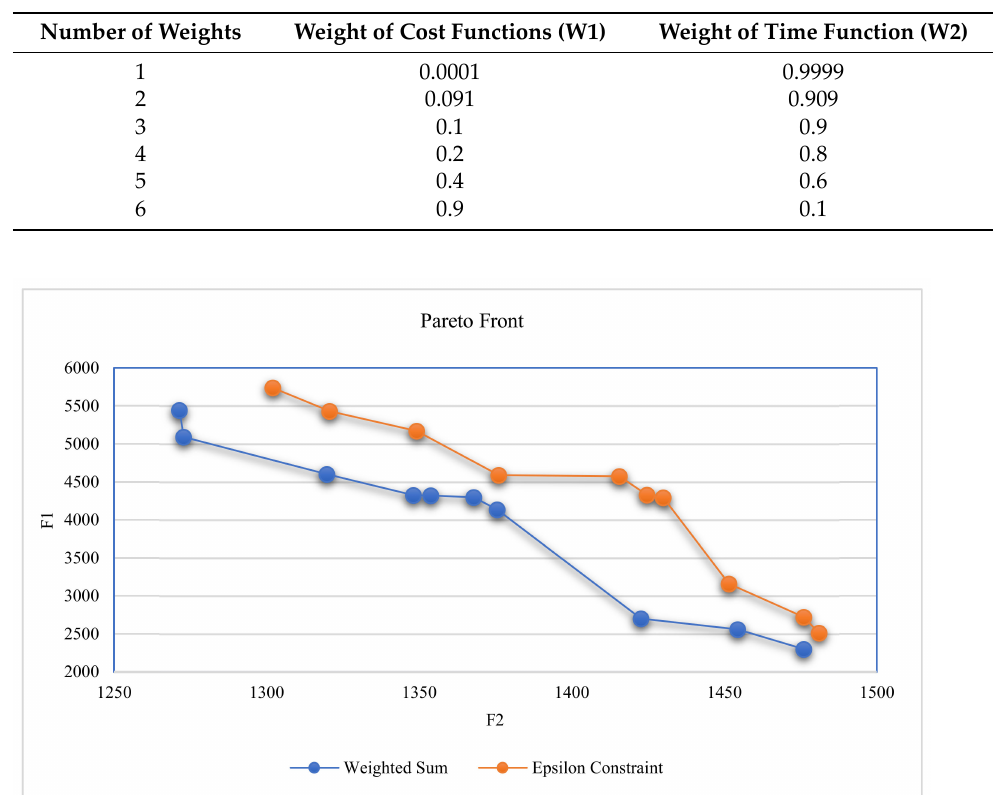
Table 4. Weights of objective functions in weighted sum method.